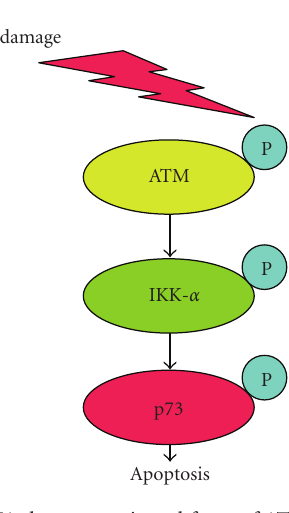
Figure 4: Upon DNA damage, activated form of ATM phosphory- lates IKK- α and promotes nuclear accumulation of IKK- α . IKK- α enhances transactivation as well as proapoptotic function of p73 in a p53-independent